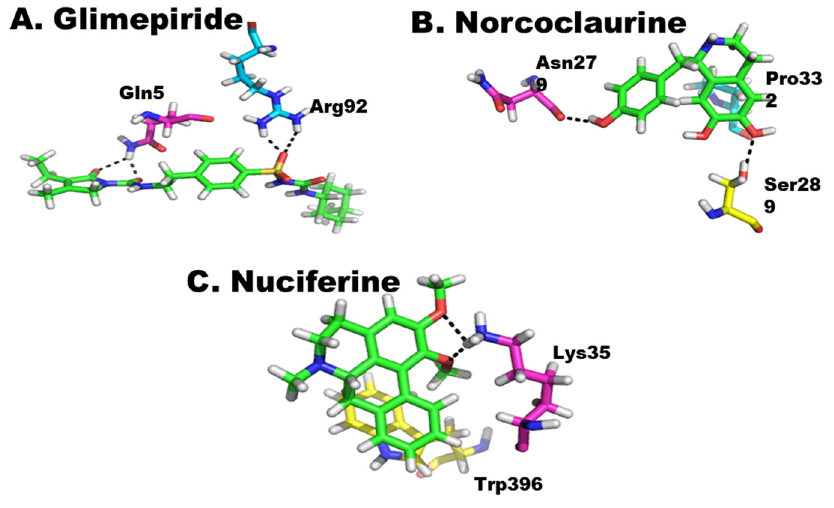
Figure 3. ( A – C ) Protein–ligand interaction of α -amylase. The green color shows the